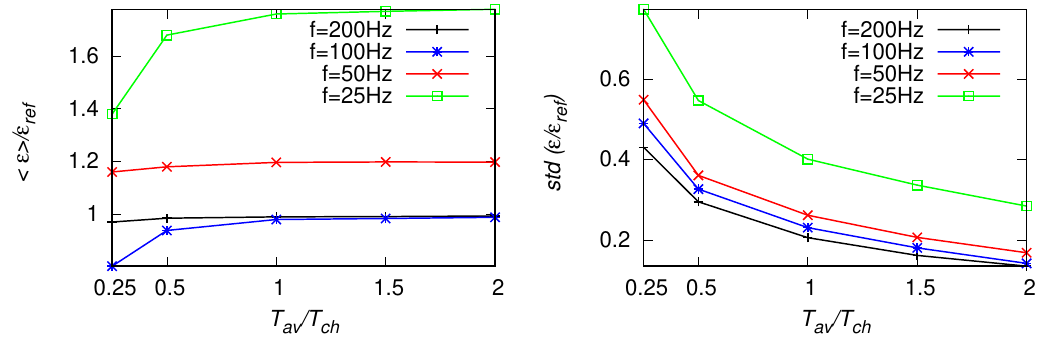
Figure 8. As in Figure 7, but for the fitting range f = [ 5 ÷ 10 ]